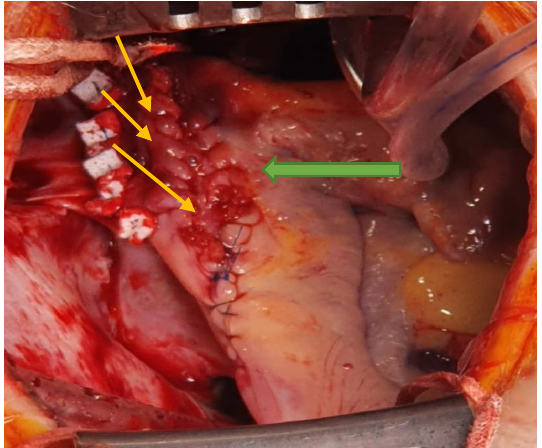
Figure 6. Right atrial and SVC enlargement plasty, reinforced with PTFE patches (yellow arrows), using a fresh autologus pericardial patch (green arrow).